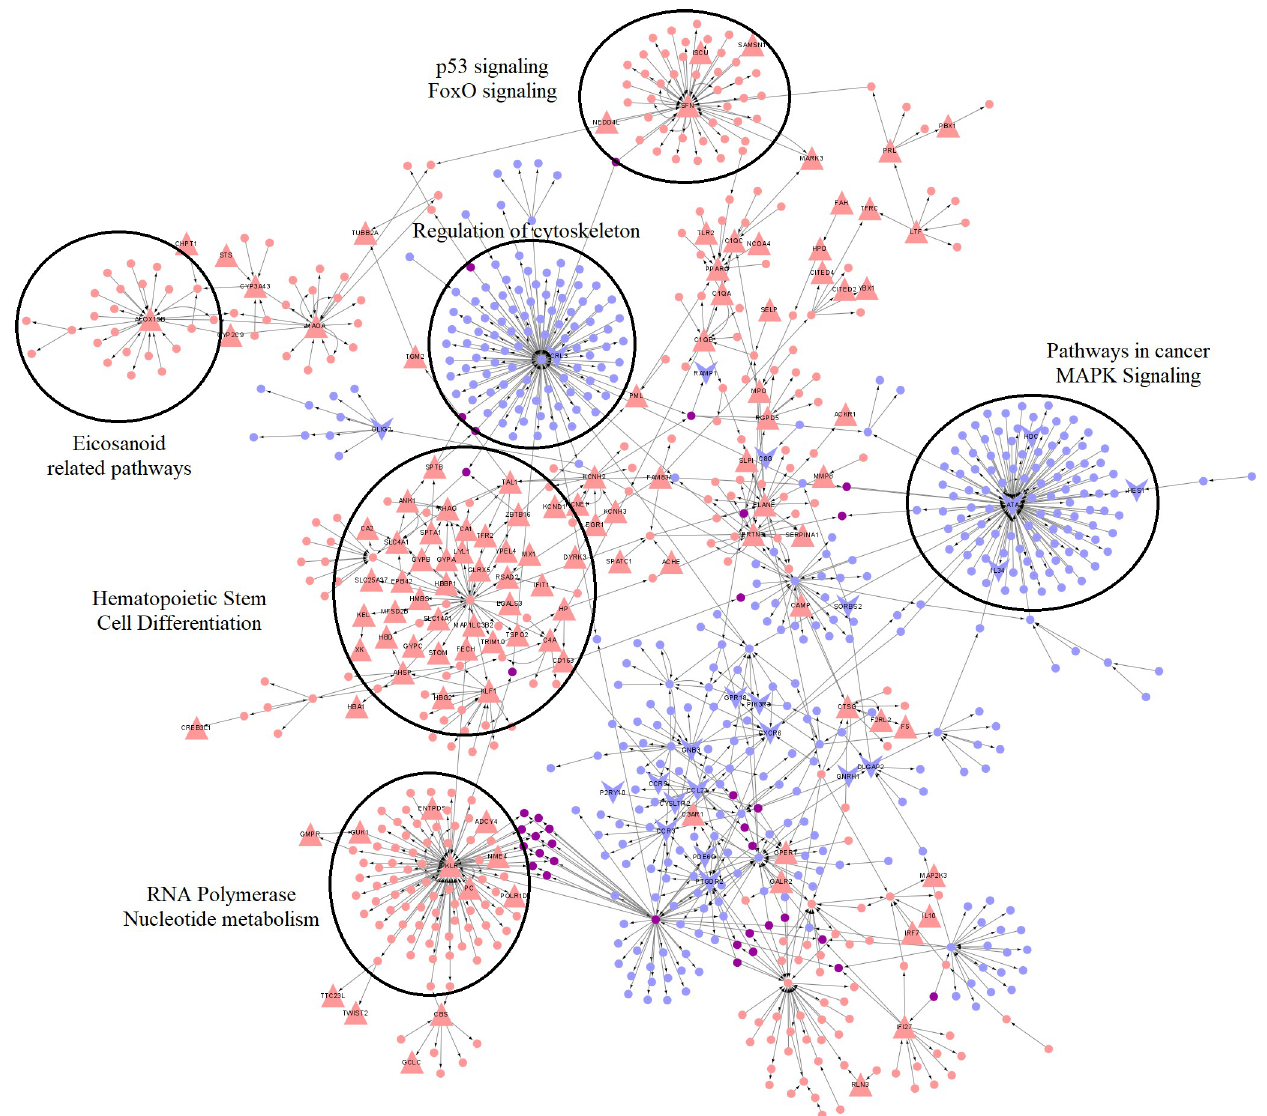
Fig 3. TopNet for ARF vs. Healthy. The red nodes represent genes in the top active network, the blue nodes represent nodes of the top repressed network, and the purple nodes indicate nodes common to both. The upper-facing triangles represent upregulated genes, and lower-facings ones indicate downregulated genes in each test condition compared to the reference groups. The DEGs are marked with a larger node size. Enrichment of some of the hub genes has also been shown.